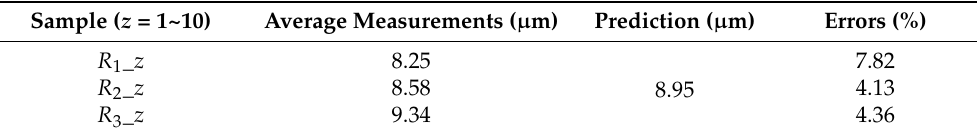
Figure 11. Theoretical and average experimental results of the surface profile of the ME samples parallel to the fiber direction.